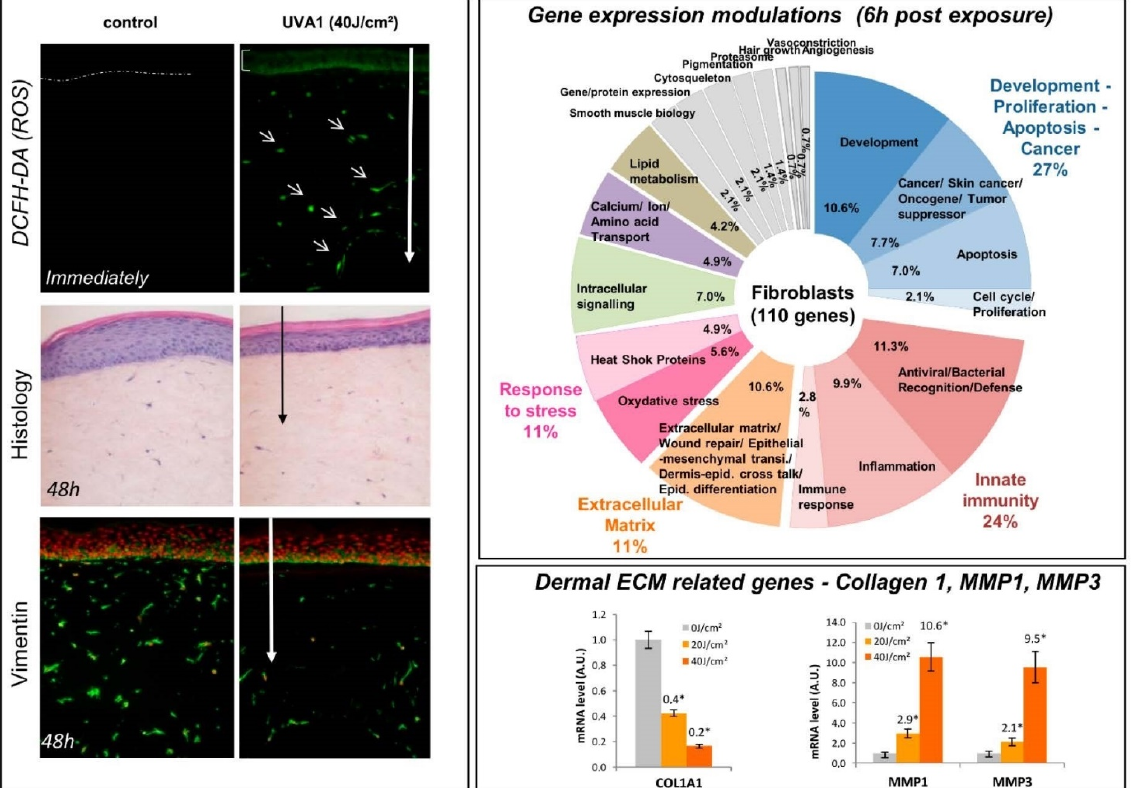
Figure 4. Dermal damages induced by UVA1 exposure in a reconstructed skin model. Due to their high penetration properties, UVA1 rays can reach the dermis. In a reconstructed skin model, it was possible to visualize the impact of UVA1 exposure thanks to the three-dimensional architecture of such model [33] . ROS generation can be observed within dermal fibroblasts immediately after the exposure to UVA1 (DCFH-DA staining), along with morphological alterations including the disappearance of dermal fibroblasts at 48 h (Histology and Vimentin staining). A full genome transcriptomic analysis revealed that 6 h post-UVA1 exposure a huge number of genes are modulated in fibroblasts. These modulated genes belong to various functional families such as Response to Stress, including oxidative stress, but also Extracellular Matrix, Innate Immunity and Development/Proliferation/Apoptosis/Can- cer. To illustrate the contribution of UVA1-induced dermal alterations in the photoaging process, ex- amples of modulated genes are illustrated with the downregulation of COL1A1 and the upregulation of MMP1 and MMP3. Small arrows: dermal fibroblasts containing ROS. Long arrows indicate the depth of UVA1 penetration. * Significant statistical difference ( p < 0.05).